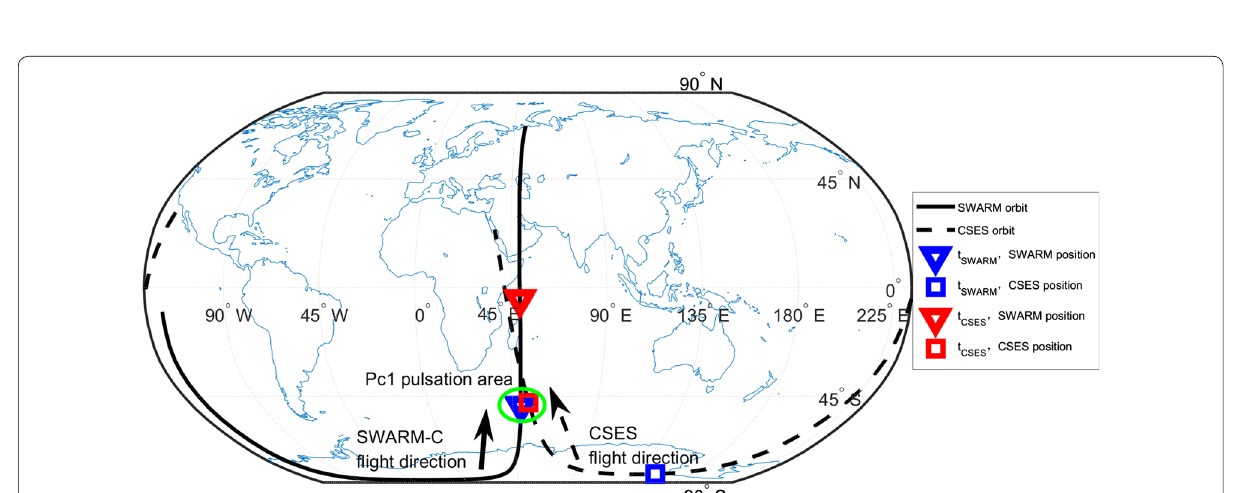
Fig. 23 Positions of CSES and SWARM when they observed the Pc1